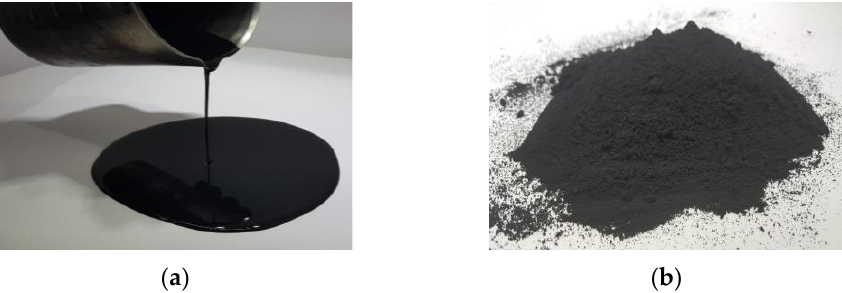
Figure 2. Waste oil and waste rubber forms. ( a ) Waste oil (engine oil) liquid. ( b ) Waste rubber (EPDM) powder.